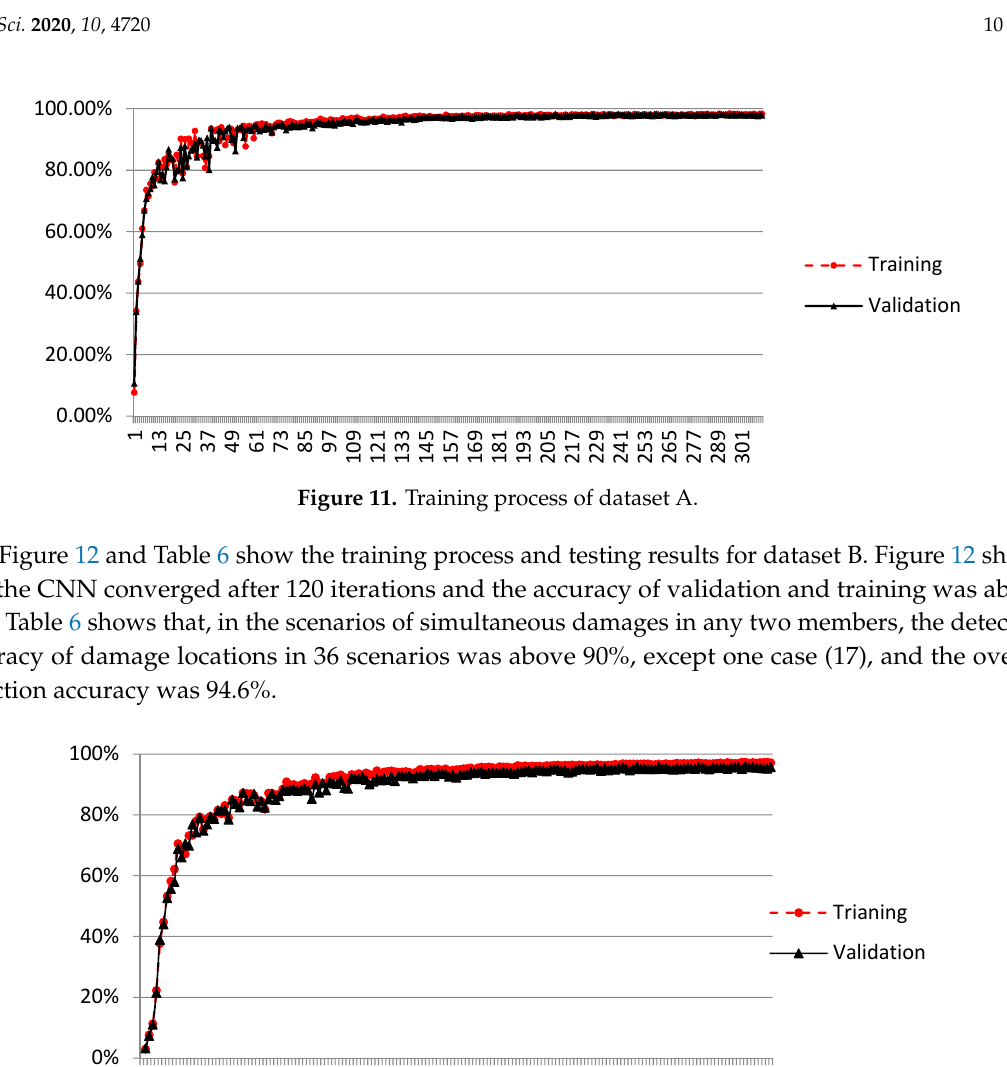
Figure 11. Training process of dataset A. Table 5. Detection results of dataset A.